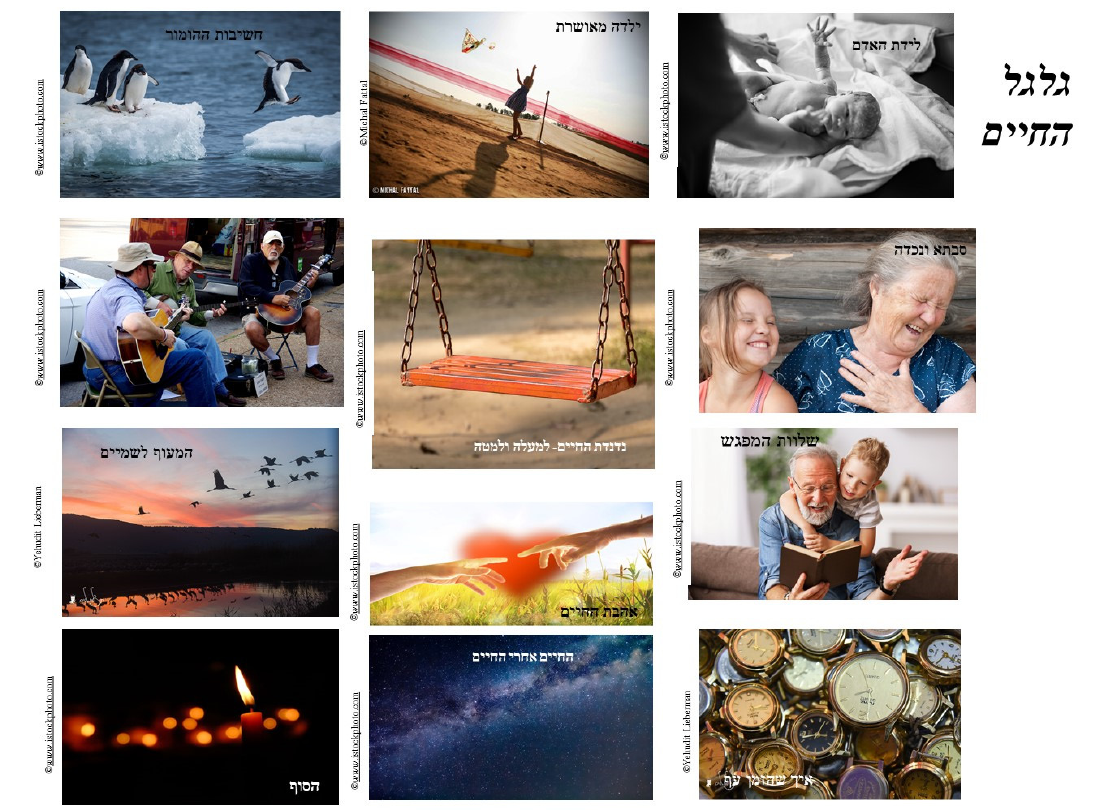
Titles from top row, presented from left to right: “The importance of humor”; “A very happy girl”; “The birth of a person”. Titles from second row, presented from left to right: “no title”; “The swing of life, up and down”; “Grandmother and granddaughter”. The titles from third row, presented from left to right: “The flight to the sky”; “Love for life”; “Peace of mind”. Titles from the bottom row, presented from left to right: “The end”; Life after life”; “How time flies” Figure 9. Lea’s photocollage: “The wheel of life” . Reproduced with permission from Michal Fattal, Yehudit Liberman and www.istockphoto.com (accessed on 5 June 2021; 29 June 2021; 16 August 2021; 29 September 2021).